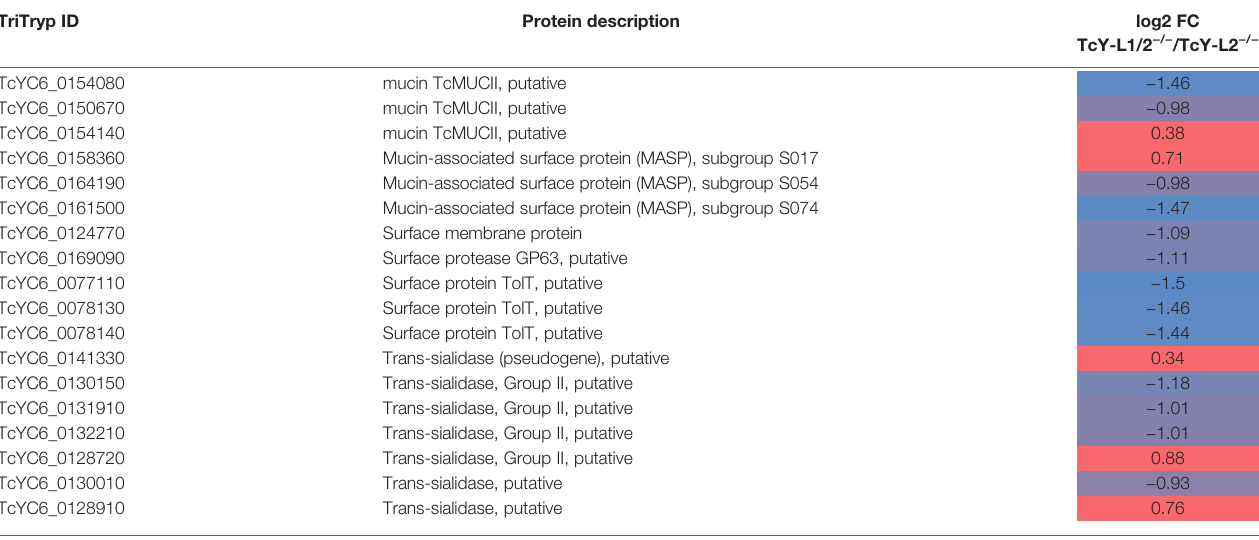
TABLE 4 | Important surface membrane proteins regulated in TcY-L1/2 − / − trypomastigotes compared to TcY-L2 − / − trypomastigotes. TriTryp